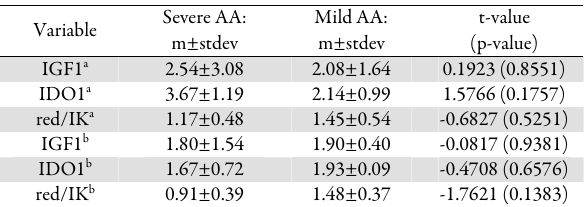
Tab. 2. Mean fold change values for IGF1, IDO1 and red/IK genes- comparisons between pairs of data and type of AA